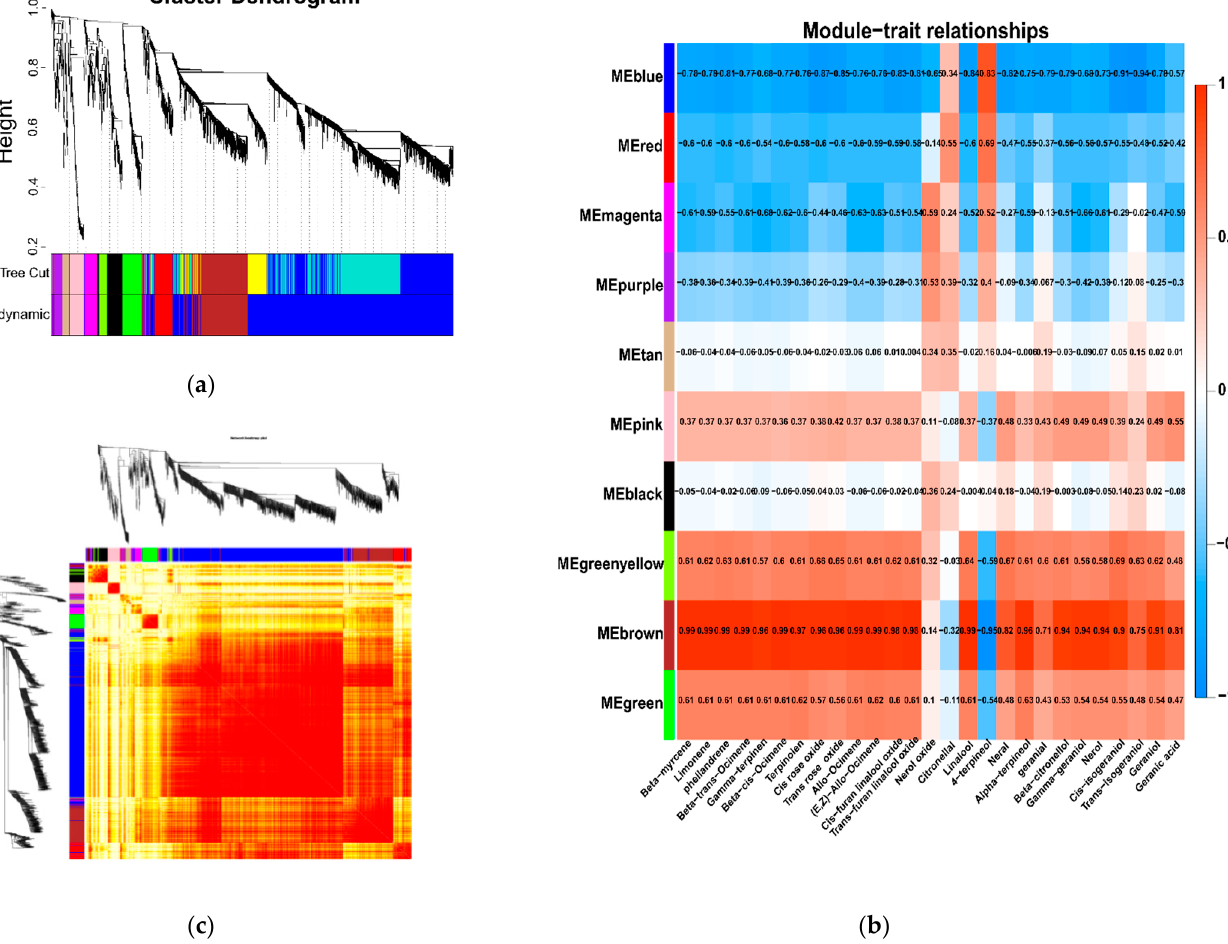
Figure 8. Weighted genes co-expression network analysis (WGCNA) of DEGs. ( a ) Hierarchical clustering tree using the topological overlap dissimilarity, tree branches have been colored by module membership. ( b ) Module–monoterpene relationship. Each row represents a module, and the number of genes in each module is shown on the left. Each column represents a specific monoterpene profile (total of their free and bound forms). The left panel shows 10 modules and the right panel is a color scale for module trait correlation from − 1 to 1. Each cell was colored based on the statistical significance and labeled with two numbers. The upper number indicates the correlation coefficient and the lower number indicates the p -value. ( c ) Heatmap plot of topological overlap in the gene network. In the heatmap, each row and column corresponds to a gene, a light color denotes low topological overlap, and progressively darker red denotes a higher topological overlap. Darker squares along the diagonal correspond to modules. The gene dendrogram and module assignment are shown along the left and top.